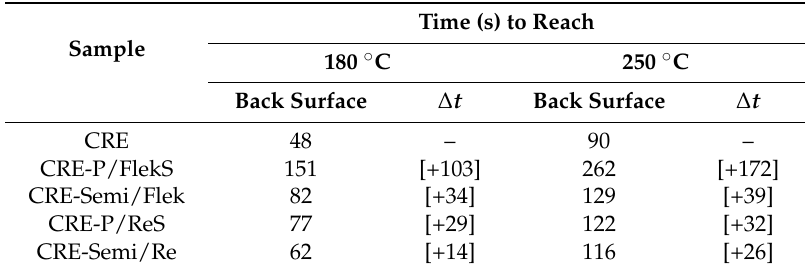
Table 3. The time required to reach the selected temperatures at the surface and back surface of all CRE samples at 35 kW/m 2 heat flux.